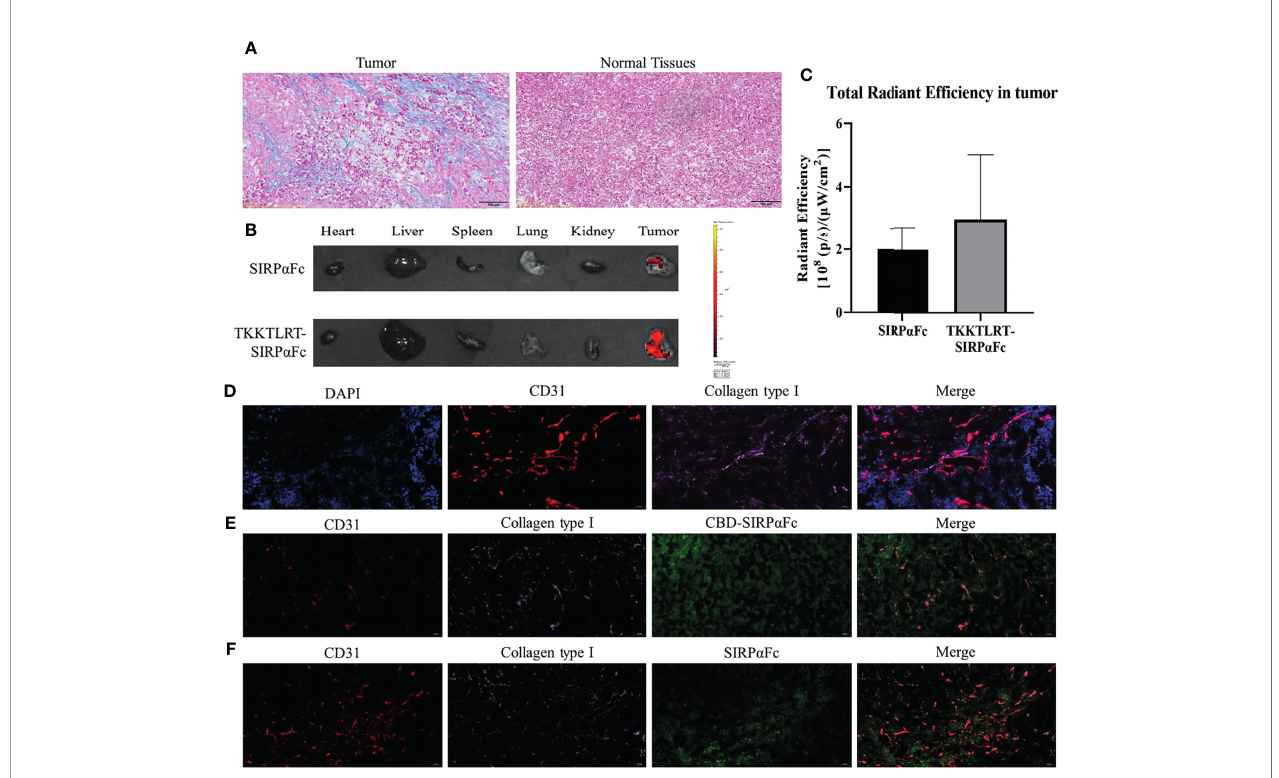
FIGURE 4 | Collagen was abundant in tumors where CBD – SIRP a Fc would accumulate. (A) Masson-trichrome staining showed collagenous fi ber (blue) and muscle fi ber (red) in tumors and paired normal tissues. Collagen was largely distributed in tumors compared to normal tissues. (B, C) FITC-labeled SIRP a Fc and CBD – SIRP a Fc distributed in tumor, and main organs at 2 h after intraperitoneal injection were detected, when more CBD – SIRP a Fc accumulated in tumor than SIRP a Fc (n = 3) (B) . Total radiant ef fi ciency in tumor was measured with Living Image software and counted with GraphPad Prism 8 software (C) . (D) Immuno fl uorescent staining showed cell nucleus (blue), blood vessels (indicated by CD31, red), and collagen type I (pink) in tumor. Collagen was abundant and tended to be around vessels. (E, F) Immuno fl uorescent staining on tumors at 4 h after injection showed FITC-labeled SIRP a Fc (E) or CBD – SIRP a Fc (F) in tumor. Blood vessels indicated by CD31 were stained red and collagen type I was stained pink, while SIRP a Fc and CBD – SIRP a Fc were green. More CBD – SIRP a Fc accumulated in tumor than SIRP a Fc and distributed mainly around